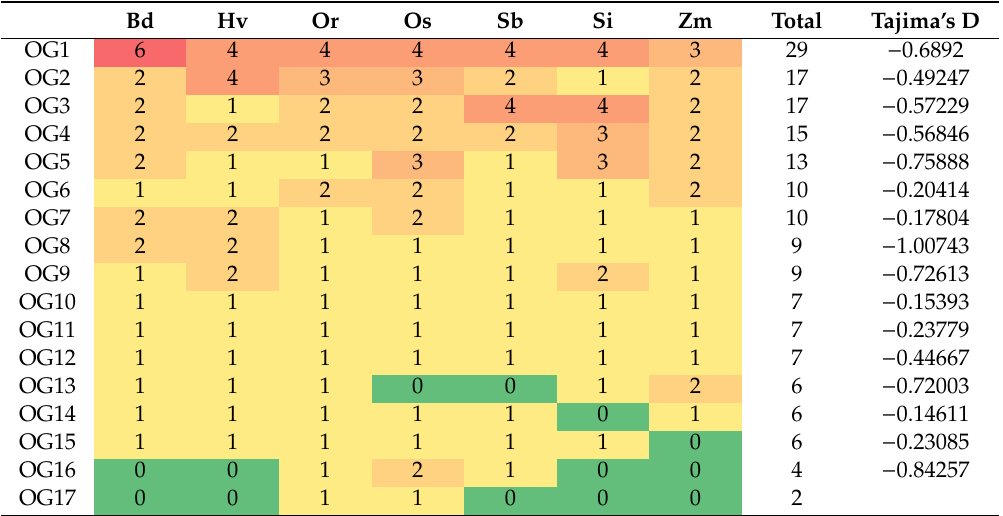
Table 2. Numbers and Tajima’s D values of all orthologous groups (OGs) among seven tested